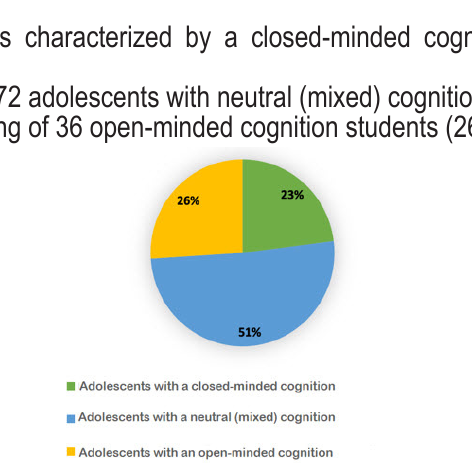
Figure 1. Grouping of adolescents with different cognition